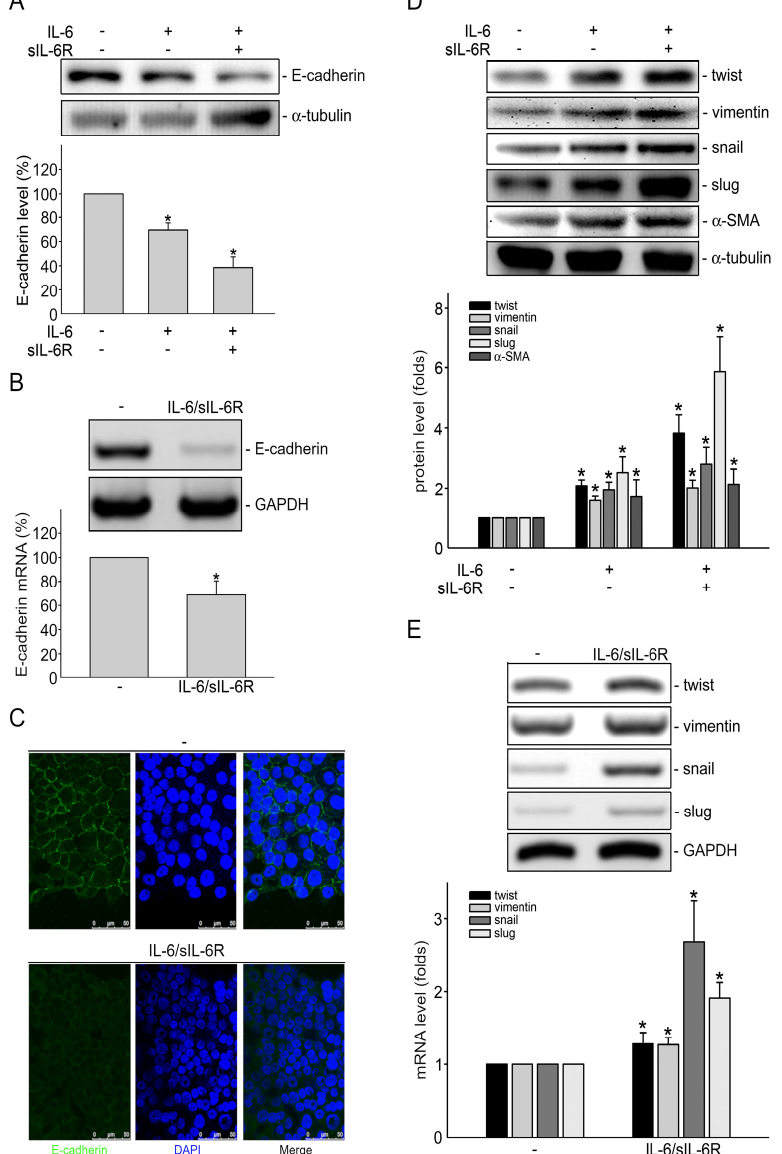
Figure 1. IL-6 induces epithelial–mesenchymal transition (EMT) in HCT116 colorectal cancer cells. ( A ) After 72 h treatment of vehicle with IL-6 (20 ng/mL) or IL-6 plus sIL6R (20 ng/mL), the extent of E-cadherin protein level was determined by immunoblotting. Bar graph represents the mean ± S.E.M. of six independent experiments. * p < 0.05, compared with the control group. ( B ) After 48 h stimulation of vehicle with IL-6 (20 ng/mL) or IL-6/sIL6R (20 ng/mL), HCT116 cells were harvested and RT-PCR was employed to examine E-cadherin cdh1 mRNA level as described in the “Materials and Methods” Section 4. Bar graph represents the mean ± S.E.M. of five independent experiments. * p < 0.05, compared with control group. ( C ) After treatment as described in ( A ), immunofluorescence analysis was employed to examine E-cadherin distribution as described in “Materials and Methods” Section 4. Results shown are representative of three independent experiments. ( D ) After treatment as described in ( B ). Immunoblotting was used to determine the protein levels of Twist, vimentin, snail, slug and α -SMA. Bar graph represents the mean ± S.E.M. of three independent experiments. * p < 0.05, compared with the control group. ( E ) After 24 h treatment of vehicle with IL-6 (20 ng/mL) or IL-6/sIL6R (20 ng/mL). RT-PCR was used to examine the mRNA level of twist , vimentin , snail and slug as described in Section 4. Bar graph represents the mean ± S.E.M. of three independent experiments. * p < 0.05, compared with the control group. IL-6/sIL6R: IL-6 plus